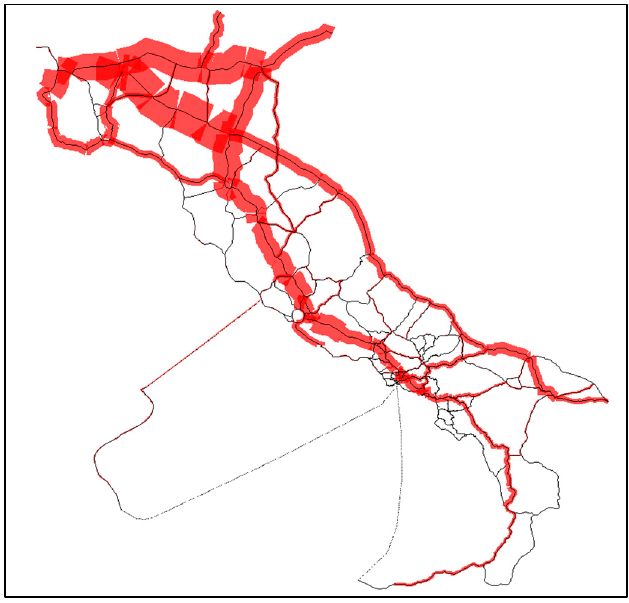
Figure 8. Freight road flows (national model).